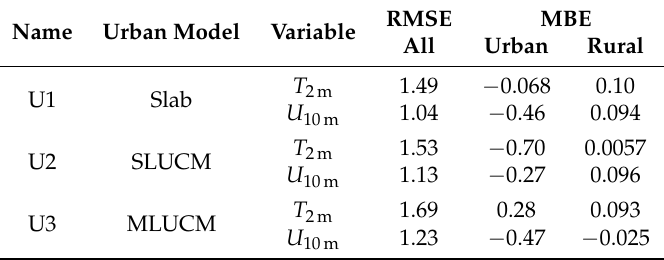
Table 11. Error metrics for temperature T 2m (in K) and wind speed U 10m (in m/s) comparing the three urban models: Slab, SLUCM and MLUCM (building environment parameterization (BEP)+building energy model (BEM)). The RMSE was calculated for all measurement stations; the MBE was calculated separately for urban and rural stations.